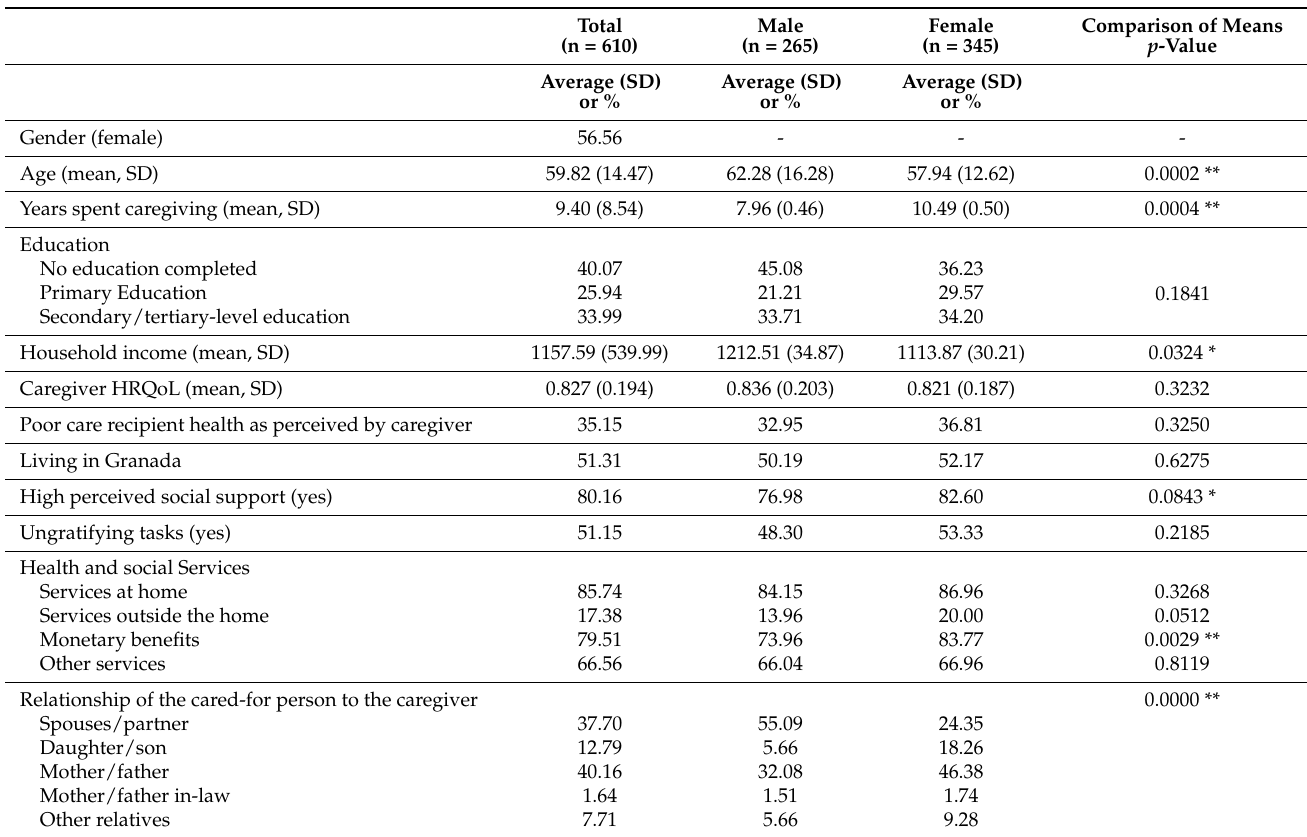
Table 1. Sociodemographic characteristics of informal caregivers.